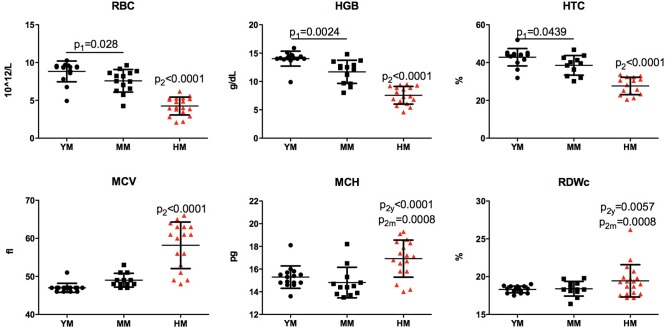
Age-dependent, irradiation and humanization-induced changes in red blood cells of NSG mice. Comparison of peripheral blood red cell count (RBC), hemoglobin concentration (HGB), hematocrit (HCT), mean (red) cell volume (MCV), the average amount of hemoglobin (mean corpuscular hemoglobin, MCV) per red blood cell and red cell distribution width (RDWc) between young 6 month old (YM), middle age 12 month old (MM) and humanized (HM) NSG mice. Mild reduction of RBC and HGB levels were found with age and significant changes corresponding to macrocytic hyperchromic anemia were observed in irradiated and transplanted with human hematopoietic stem cells (HSC) NSG mice. One-way ANOVA with post-hoc testing by Tukey's Multiple Comparison Test. Unpaired t-test with Welch's correction: p1 – differences between YM and MM; p2, p2y or p2m – difference between humanized and non-humanized, from YM and MM mice. Individual values, mean and s.d. are shown.